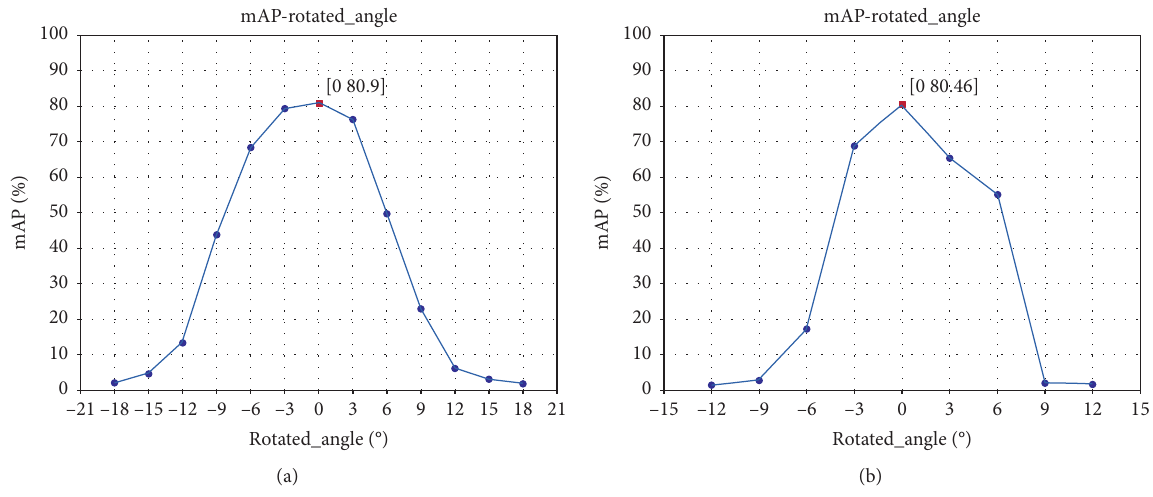
Figure 8: Recognition accuracy curve of two kinds of